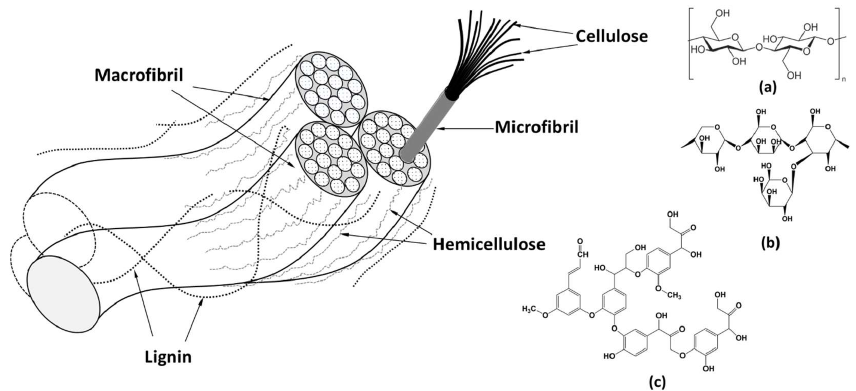
Figure 3. Fibril matrix structure of plant fiber and the chemical composition of ( a ) Cellulose; ( b ) Hemicellulose; and ( c ) Lignin.